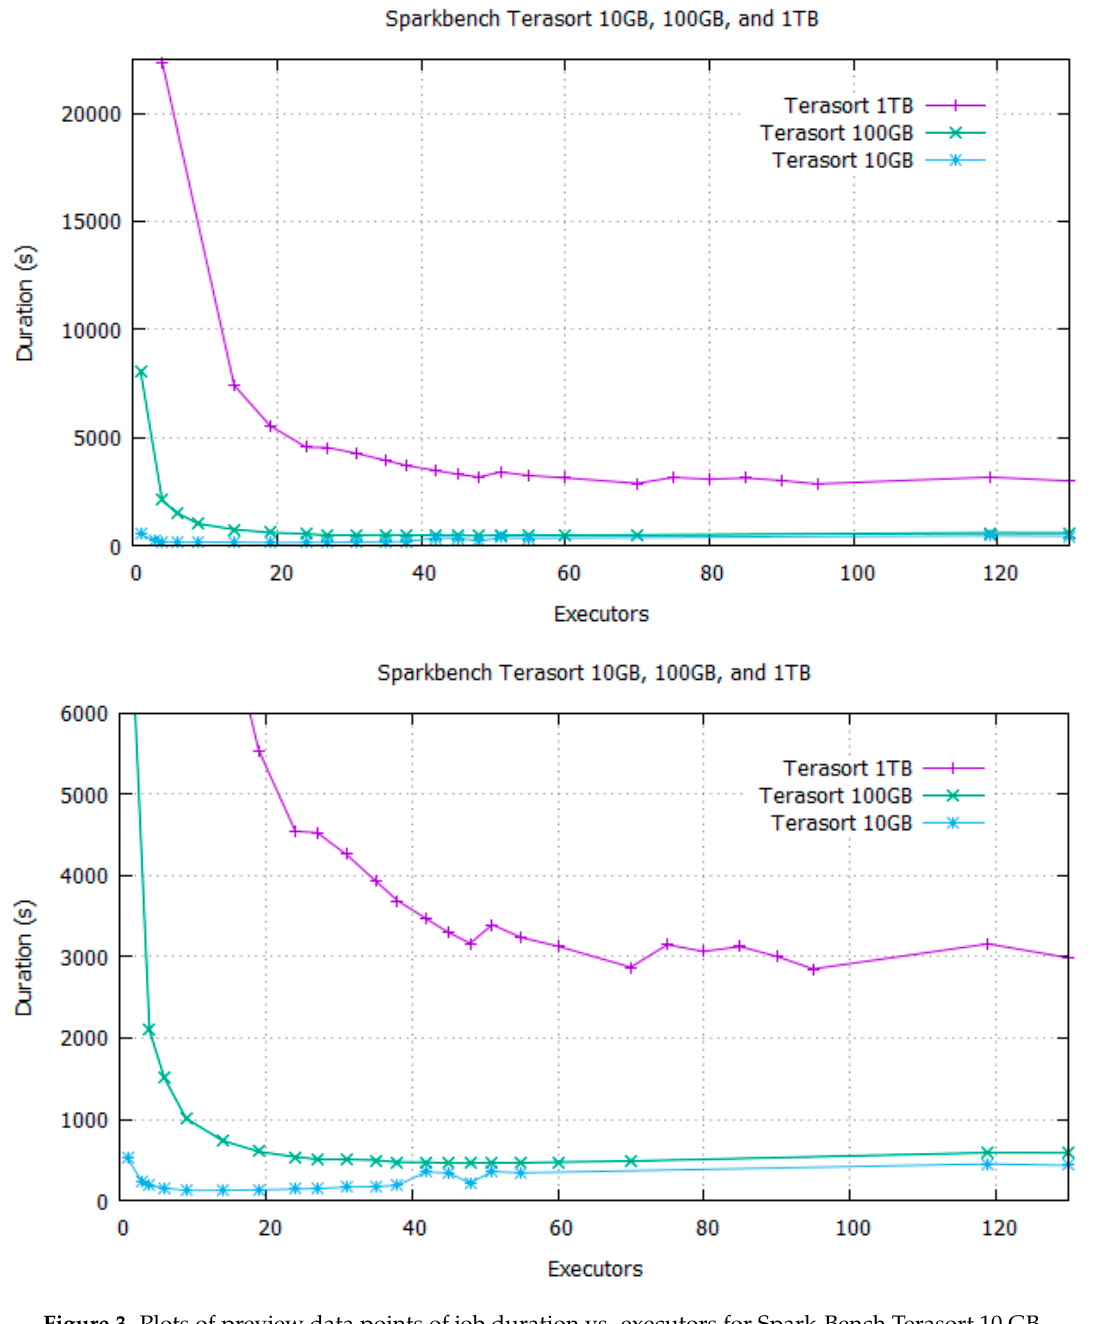
Figure 3 . Plots of preview data points of job duration vs. executors for Spark-Bench Terasort 10 GB, 100 GB and 1 TB workloads at different vertical scales.